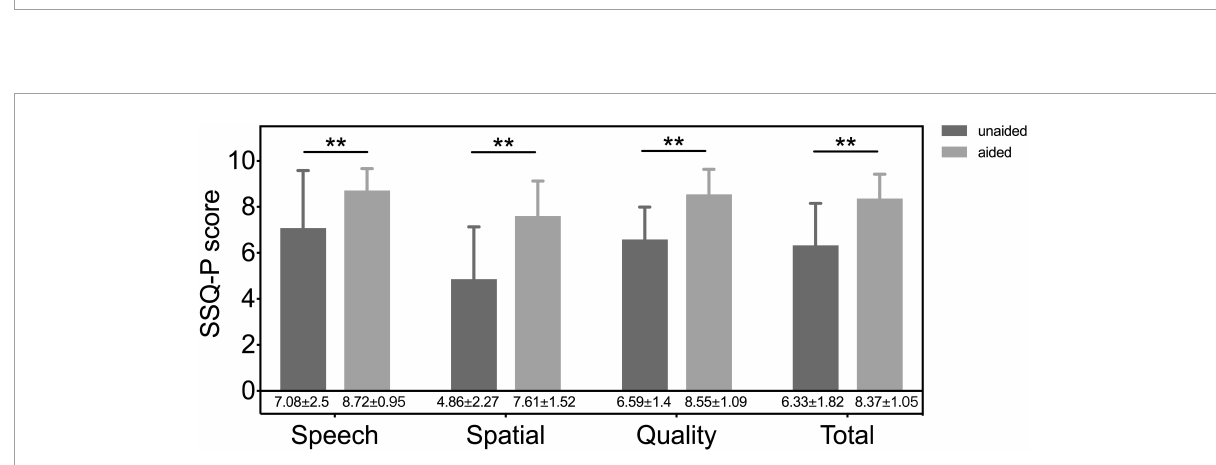
FIGURE3 The results of speech, spatial and qualities of hearing scale for parents (SSQ-p) without (unaided) and with (aided) a BCD. Significant differences, ** p < 0.01. Unaided, the unaided condition of UMA; aided, the aided condition of